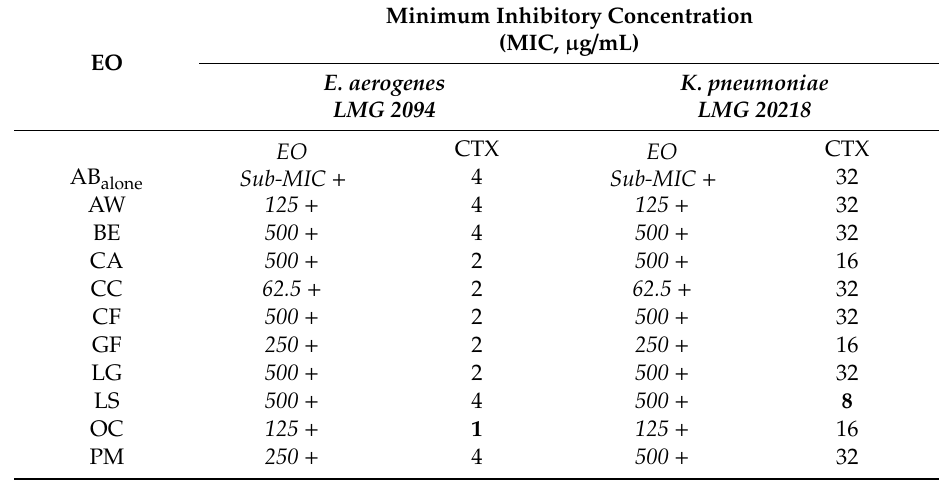
Table 5. Indirect activity of the essential oils combined at a non-active concentration (sub-MIC) with antibiotics, against E. aerogenes and K. pneumoniae ( n = 3). In bold, the most promising results. Minimum Inhibitory Concentration (MIC, µ g / mL) EO E. aerogenes LMG 2094 LMG